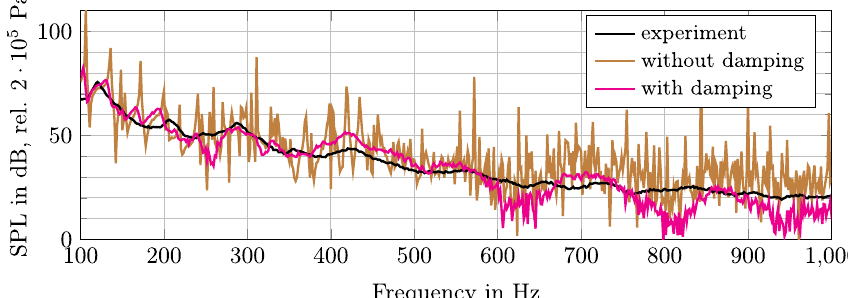
Figure 13. Comparison of different acoustic boundary conditions in the inside of the cabin.